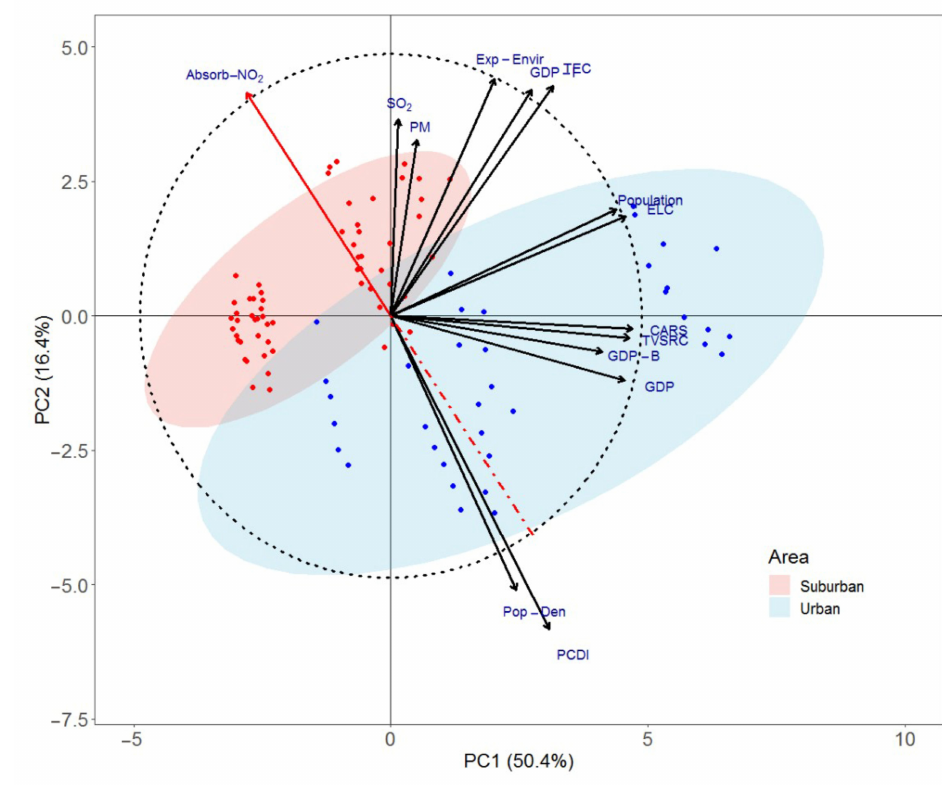
Figure 5. Biplot of PCA analysis. Annual NO 2 absorptions by urban forests of 16 districts are represented by points. Explanatory factor and absorption amount are represented by black and red arrows. The dashed circle is the equilibrium contribution circle, which is used to reflect the average contribution of all explanatory factors on the two principal component axes. Clustering results are represented by the light blue and light red 95% confidence